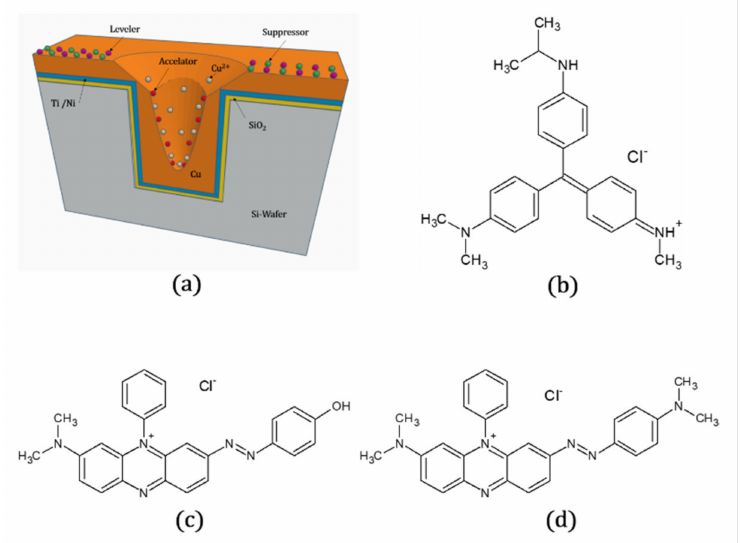
Figure 9. ( a ) Cu electro-deposition in TSV with additives; Molecular structure of levelers: ( b ) Methy- lene Violet; ( c ) Diazine Black; ( d ) Janus Green B.